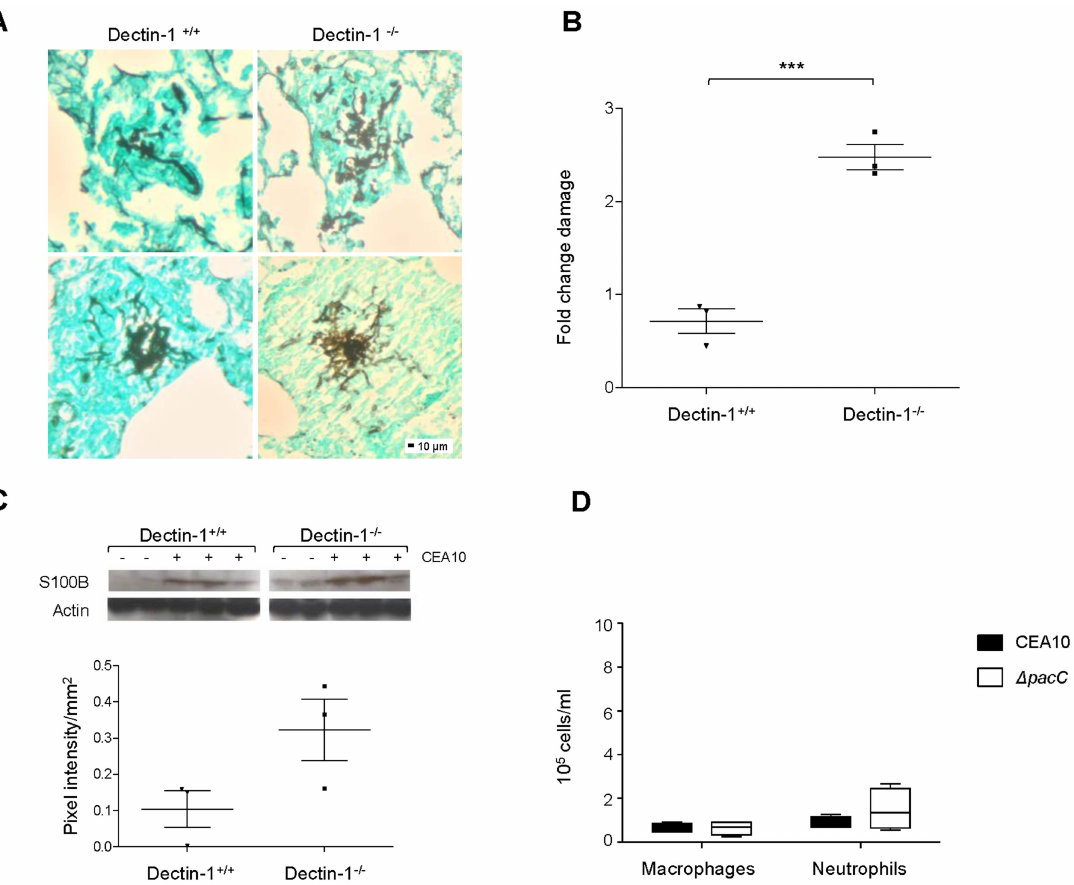
Figure 7. Internalisation and Dectin-1 protect murine pulmonary epithelia from A.fumigatus -mediated damage. (A) Histopathology of Dectin-1 2 / 2 and Dectin-1 + / + leukopenic mice (n = 3) infected with CEA10 (10 8 spores, 24 hr of infection, GMS and light green staining, 200 6 magnification). (B) LDH/BCA fold change in BALs from Dectin-1 2 / 2 and Dectin-1 + / + leukopenic mice (n = 3) infected as in B, technical triplicates. (C) S100B western blotting on lung homogenates from Dectin-1 2 / 2 and Dectin-1 + / + leukopenic mice infected as in B. Densitometry plot where pooled densitometry values for S100B were normalised on pooled densitometry values for actin and background subtracted for the saline controls. (D) Macrophages and neutrophils (cells/ml) in BALs from immunocompetent mice infected with D pacC CEA10 mutant and CEA10 (n = 4, 10 6 spores, 24 hr of infection). B and C: unpaired t test, *** p , 0.001 and * 0.01 , p , 0.05.